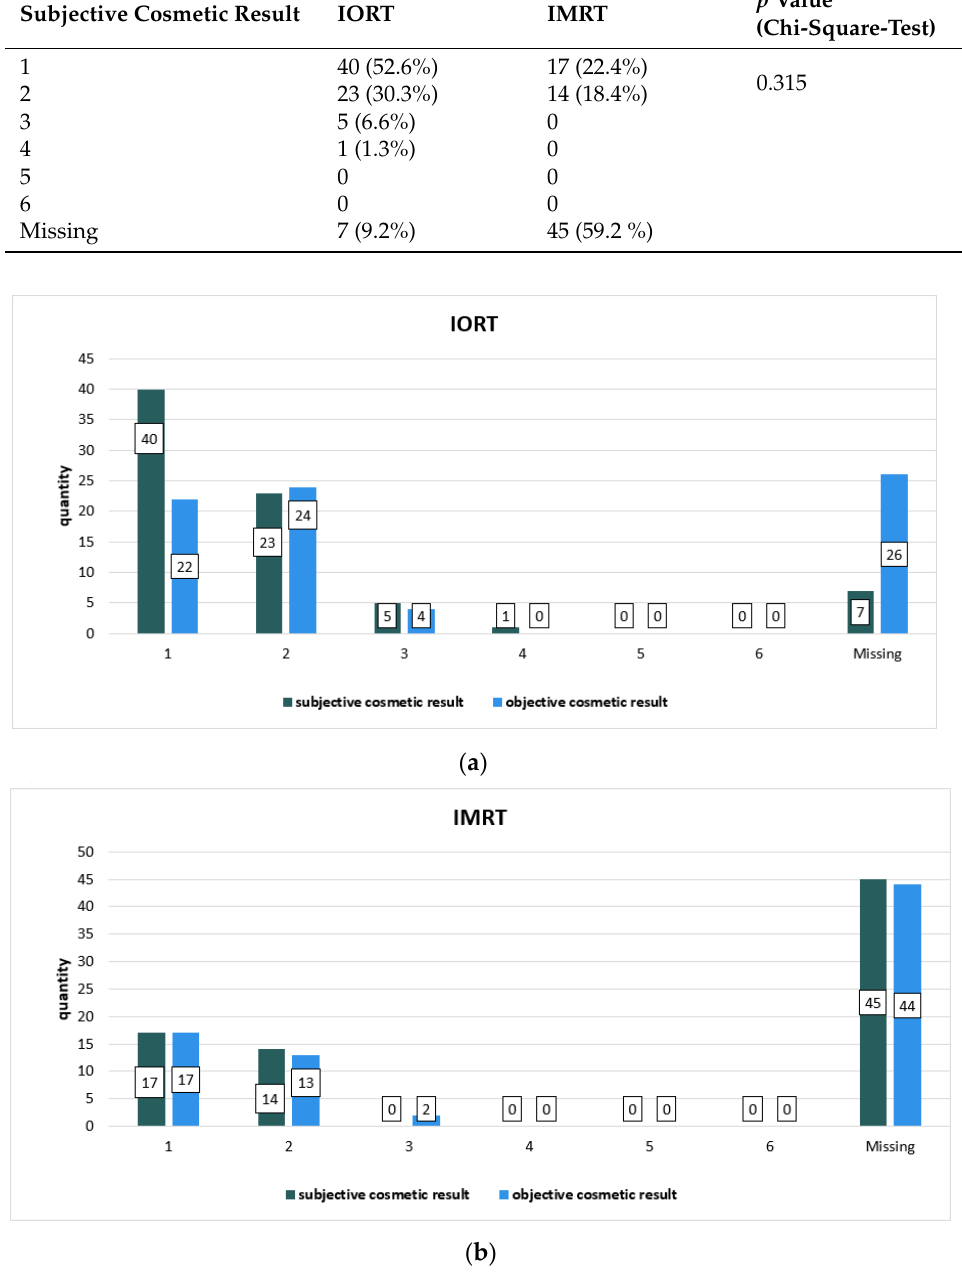
Figure 2. Graphic representation of the comparisons of subjective cosmetic results evaluated by patients during radiotherapy series and objective cosmetic results evaluated by physicians during radiotherapy series divided into subgroups: ( a ) for IORT and ( b ) for IMRT subgroups. The columns represent the number of cases.